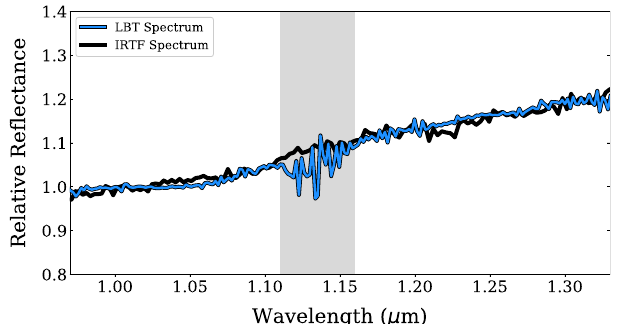
Fig. 6 Data Processing Validation with NASA Infrared Telescope Facility. our processing methods. The asteroid was fi rst observed using the SpeX instrument at the NASA Infrared Telescope Facility (IRTF) 61 and processed with SpexTool 62 . The object was then observed at LBT with the same instrument con fi guration as used to observe Kamo ʻ oalewa and is shown binned to the resolution of the SpeX data. The gray shaded region indicates the same wavelength region as indicated in Fig. 2, illustrating the effects of noise from telluric absorption features in our observing mode. Photometric errors are plotted but are not visible at this scale for this bright calibration